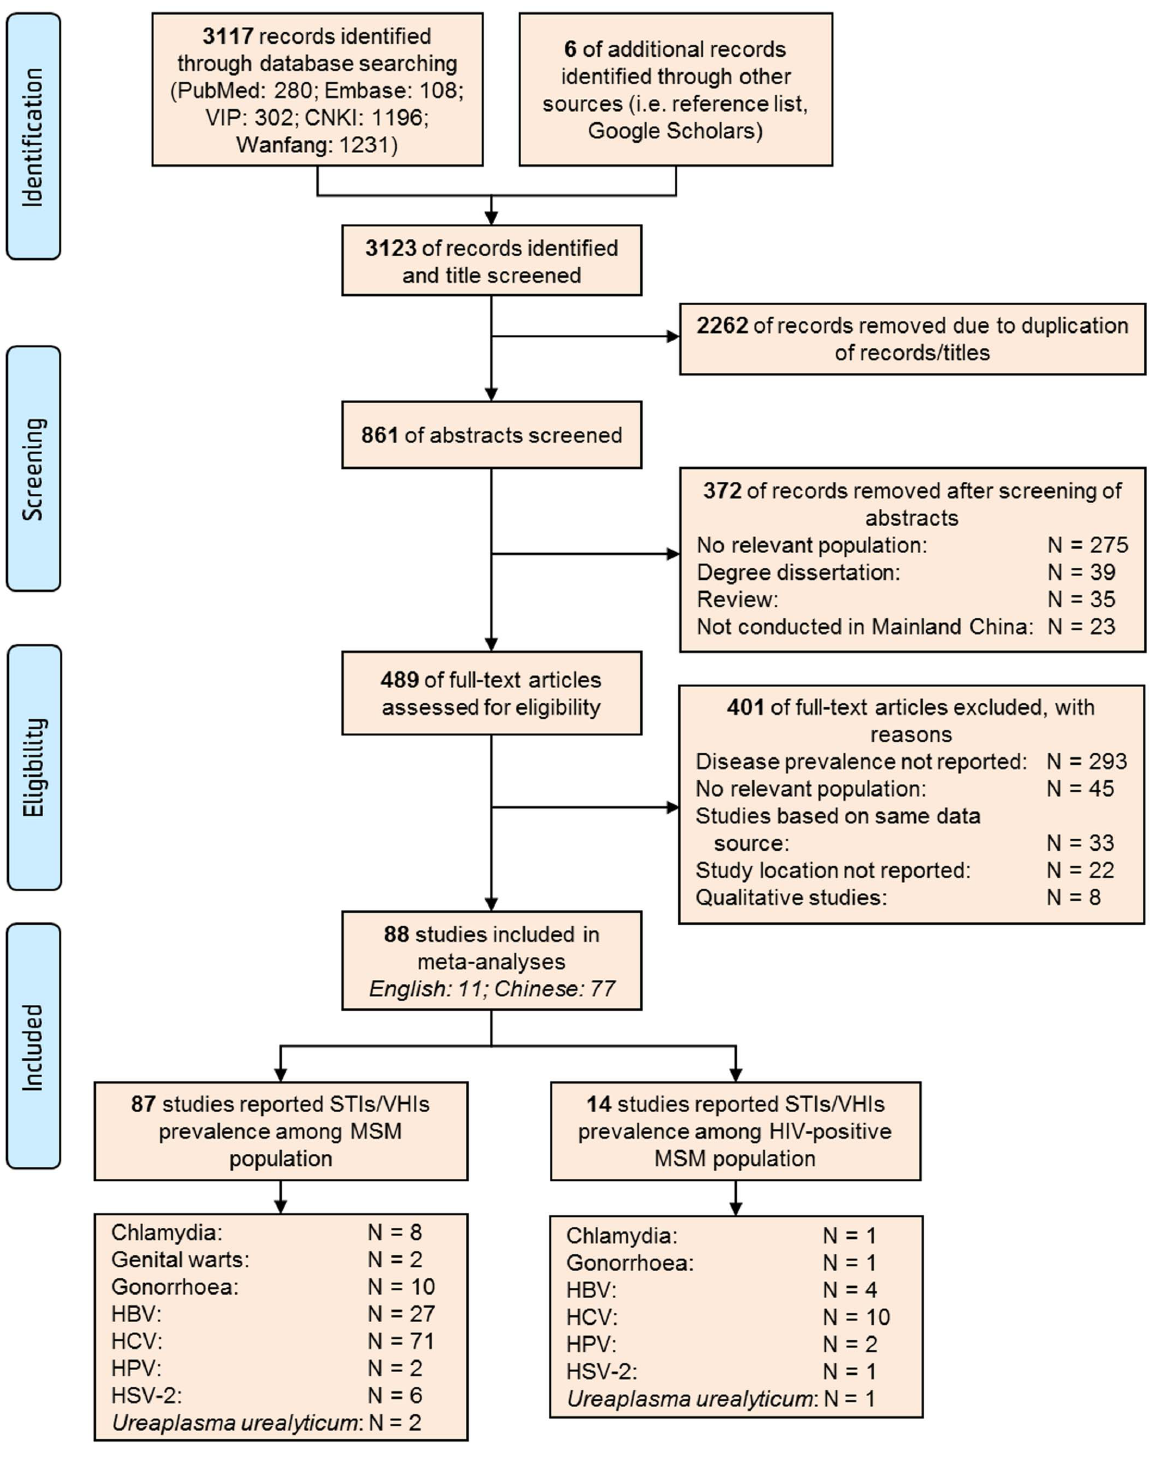
Figure 1. PRISMA flow chart for selection of studies. N represents the number of studies identified. doi:10.1371/journal.pone.0089959.g001 a percentage of the number of infections divided by the number of individuals tested for the infection. To estimate the risk of STIs acquisition in MSM, the pooled STIs prevalence estimates among MSM were compared with MSW and the general population.